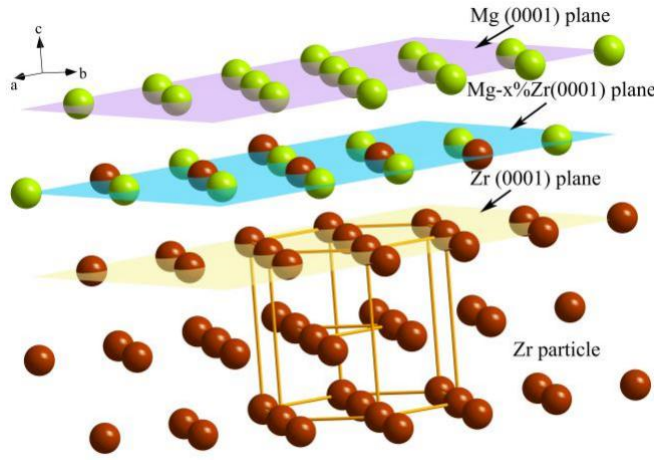
Figure 8. Schematic diagram of the atomic mechanism of heterogeneous nucleation in an Mg–Zr alloy.